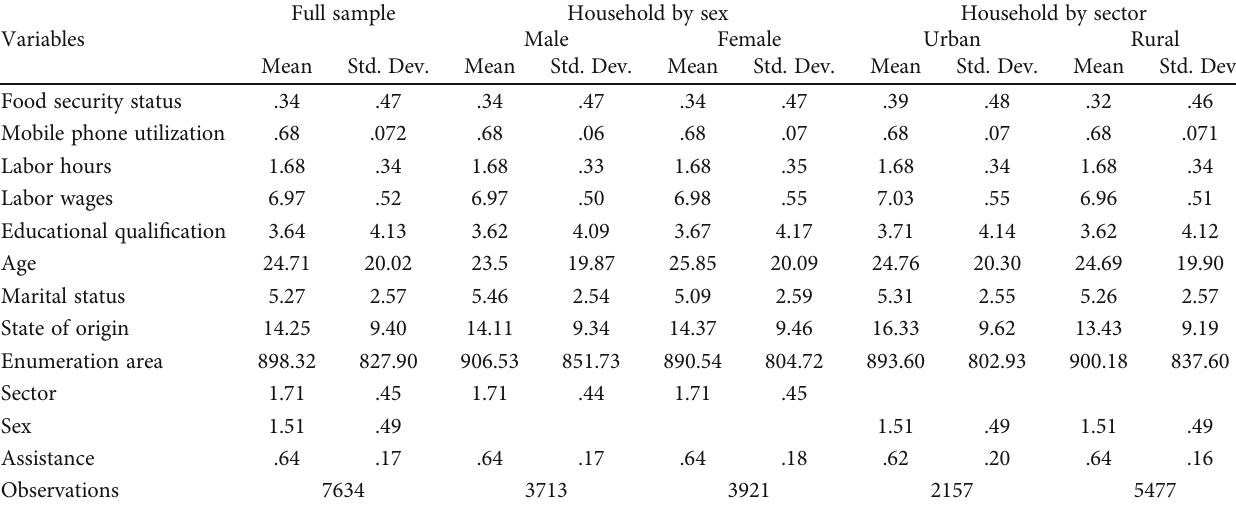
Table 3: Summary